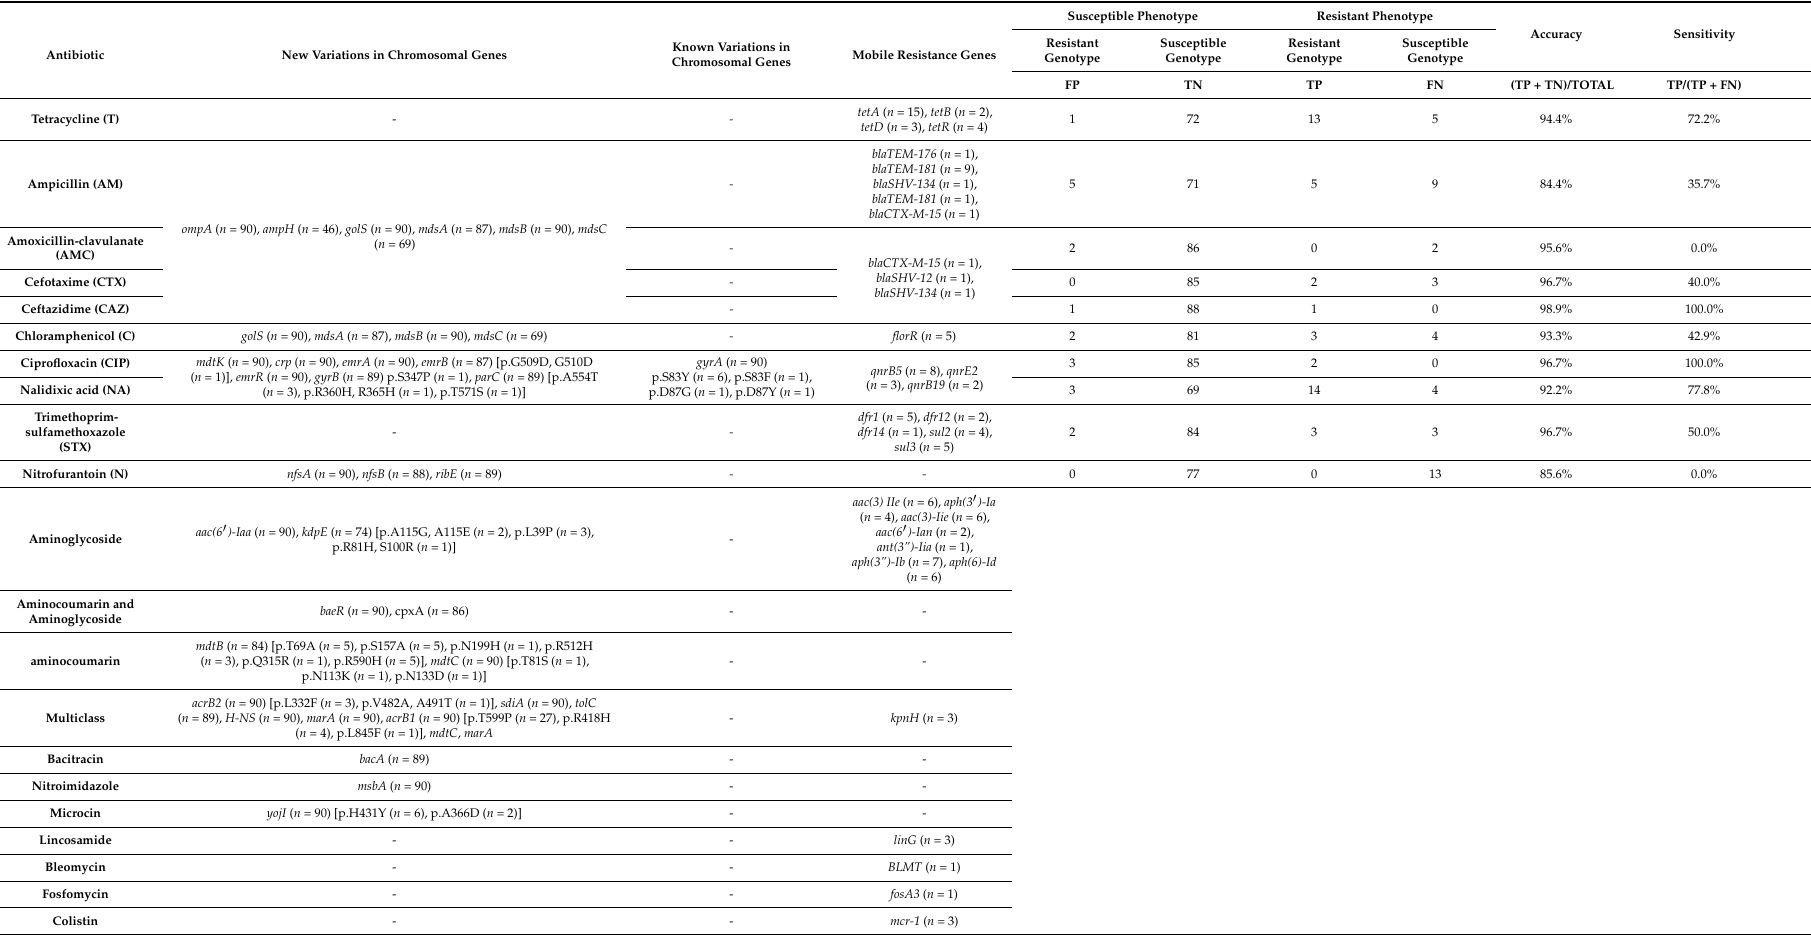
Table 1. The genotype to phenotype concordance using accuracy, sensitivity, and specificity for Peruvian isolates for ten tested